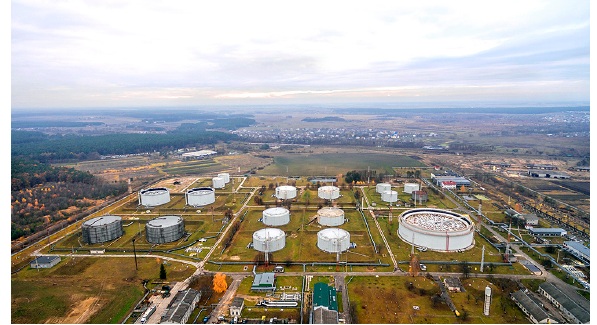
Figure 1. Tank field of LODS “Brody” company